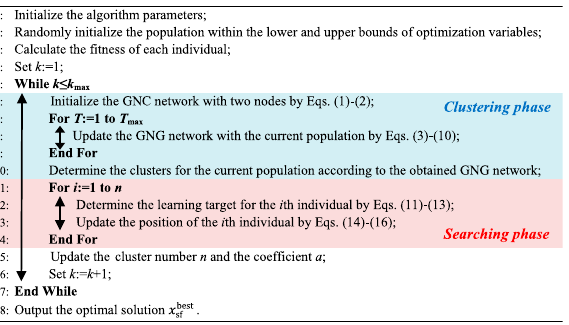
Algorithm 1 Pseudocode of LALO